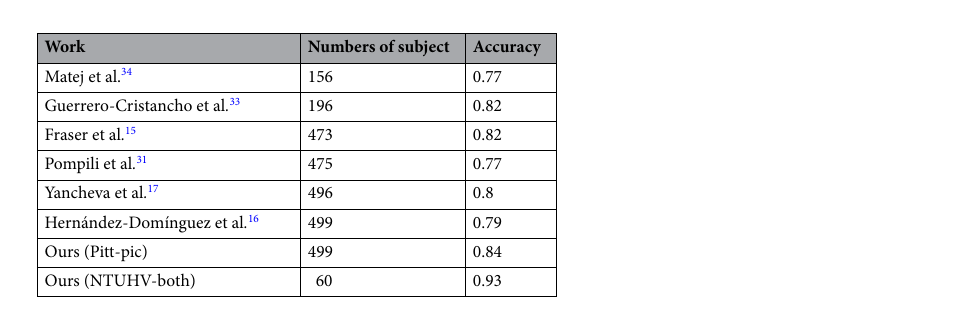
Table 6. Related works of the performance of AD vs. HC on Pitt datasets.